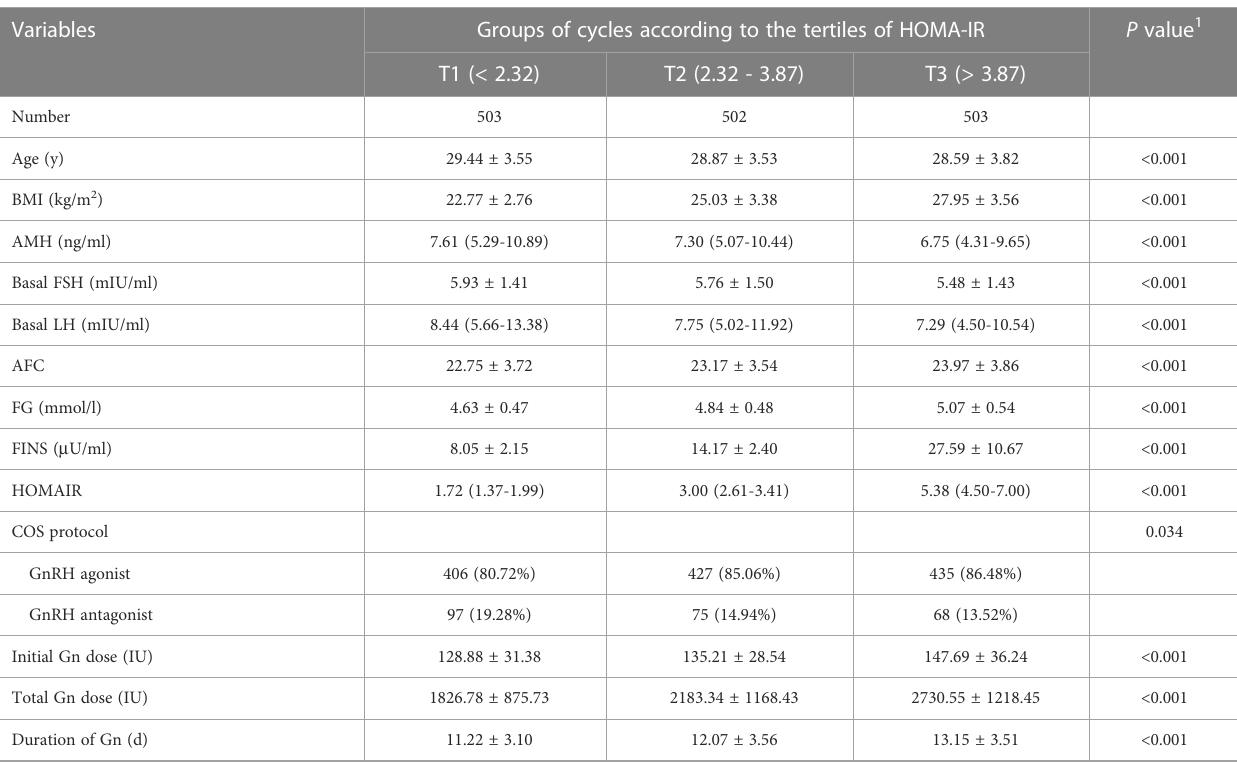
TABLE 1 The clinical parameters of the study population. Variables Groups of cycles according to the tertiles of HOMA-IR P value 1 T1 (<